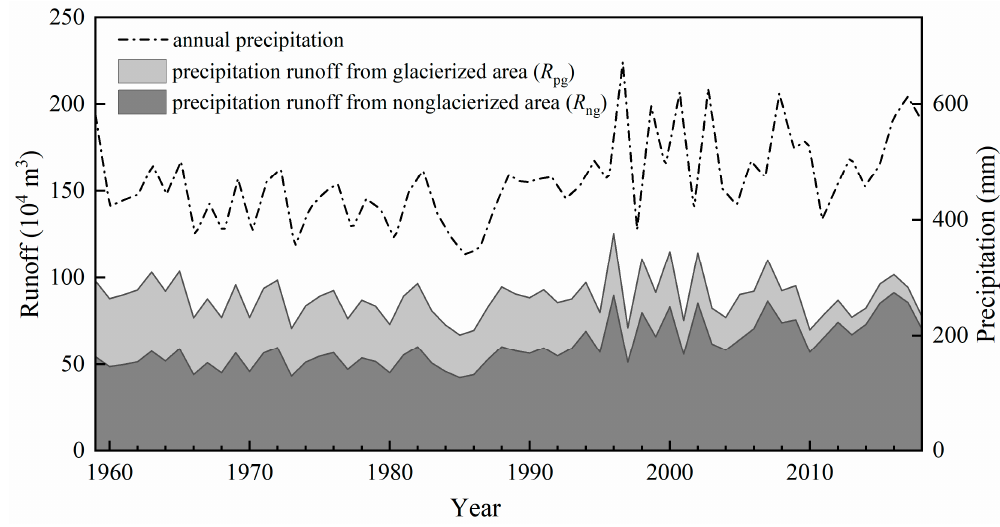
Figure 5. Variations of annual precipitation and precipitation runoff derived from the glacierized area (R pg ) and nonglacierized areas ( R ng ) from 1959 to 2018.